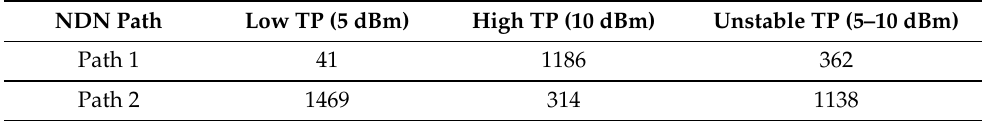
Table 4. Reactive’s solution path choices over 1500 interest-data